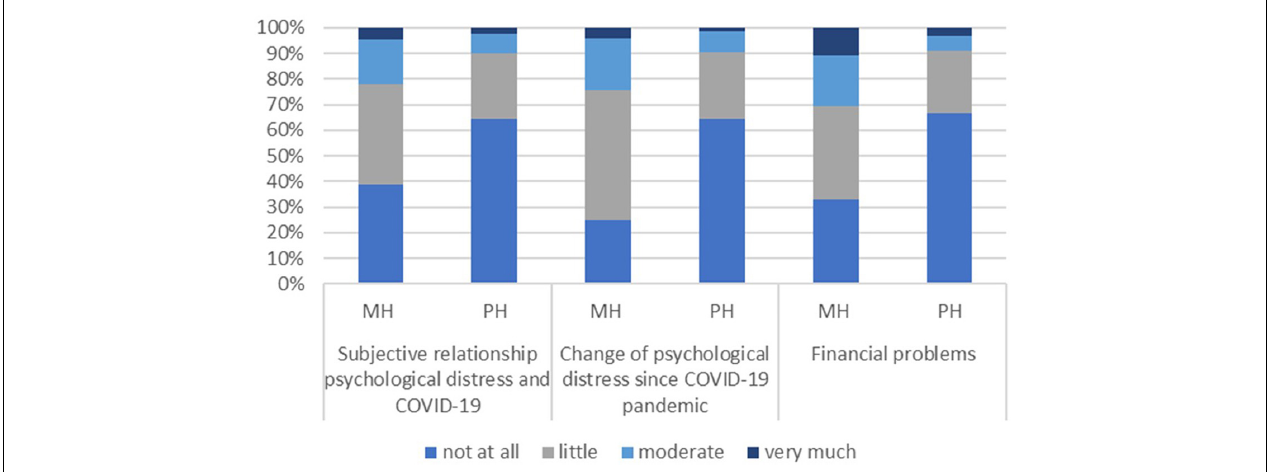
FIGURE 1 | Psychological distress and financial problems during the COVID-19 pandemic in patients with mental health (MH) and physical health conditions (PH).